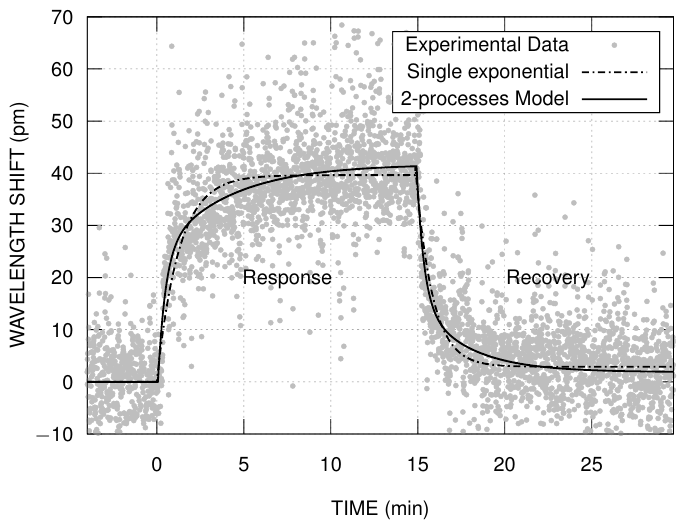
Figure 5. Comparison between the two fitting models used to study the sensor’s response with ammonia vapor at